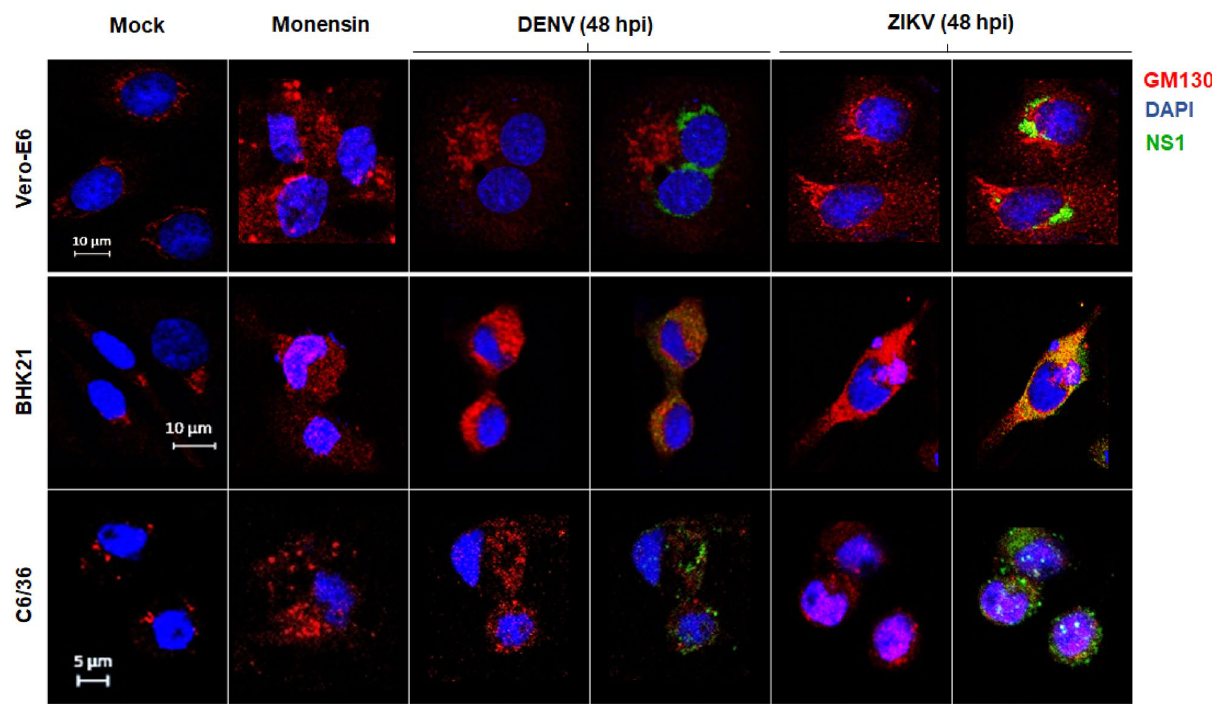
Figure 1. Golgi stress response due to flavivirus infection in vertebrate and mosquito cells. Cells were either treated with monensin and fixed at 24 h or infected with DENV and ZIKV at MOI = 3 and fixed at 48 hpi. Cells were probed against flavivirus NS1 (green), and GM130 (cis-Golgi, red). Nuclei were counter stained with DAPI (blue). Merged fluorescent images of DAPI, red and green channels are shown. The images were analyzed